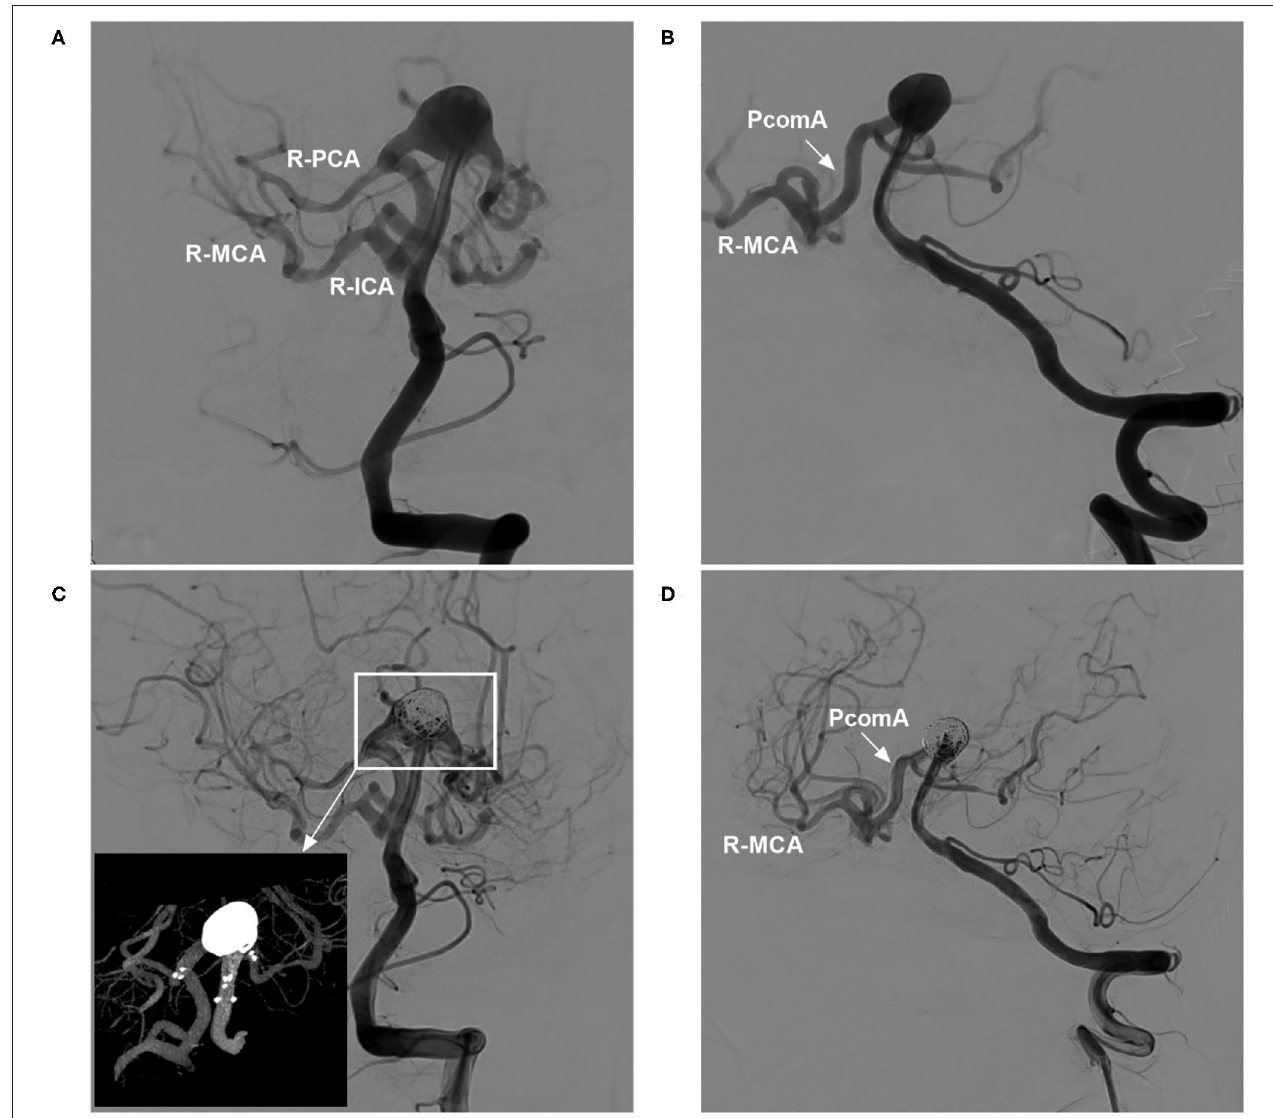
FIGURE 5 | Cross Y-stent-assisted coiling of a basilar apex aneurysm in ICA occlusion. (A,B) DSA of the VA showing a basilar apex aneurysm, with the right ICA system supplied via the PcomA (arrow in B ) from the posterior circulation; (A) presents an approximately anteroposterior view, while B presents an oblique view. (C) DSA of the VA showing coiling of the aneurysm with the assistance of cross Y-stenting; the magnified inset (long arrow from the frame) shows the NAS and coiling. (D) DSA of the VA (oblique view) showing that the arteries around the coiled aneurysm were not affected and that the PcomA (arrow) supplied the right ICA system. DSA, digital subtraction angiography; ICA, internal carotid artery; MCA, middle cerebral artery; NAS, Neuroform Atlas stent; PCA, posterior cerebral artery; PcomA, posterior communicating artery; R, right; VA, vertebral